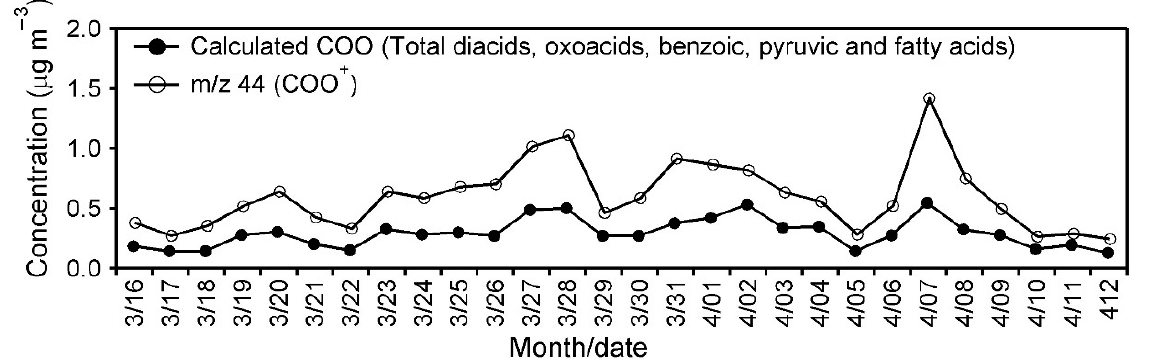
Figure 5. Temporal variations in the calculated COO of total diacids, total oxoacids, benzoic acid, and total fatty acids obtained by GC, and m/z 44 (COO + ) signals obtained by AMS.